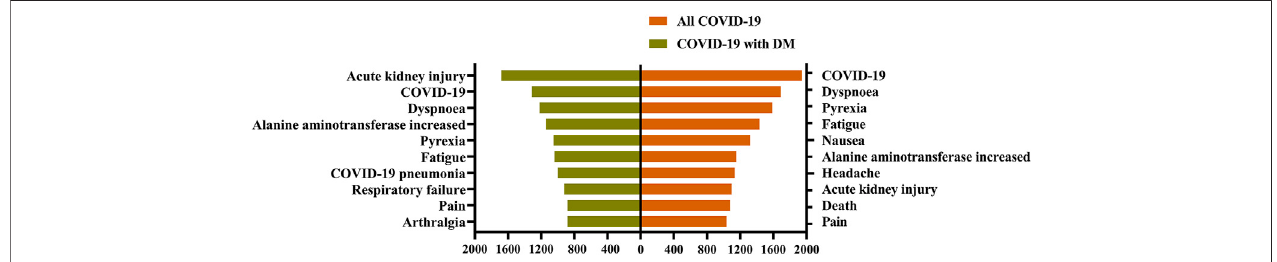
FIGURE1| Ranking ofadverse drugreactions indifferentpatients.Adversedrug reactions arevisualized onthe Y -axis,their occurrence number areshown onthe X -axis. COVID-19: coronavirus disease 2019; DM: diabetes mellitus. A report may have one or more drug adverse reactions.